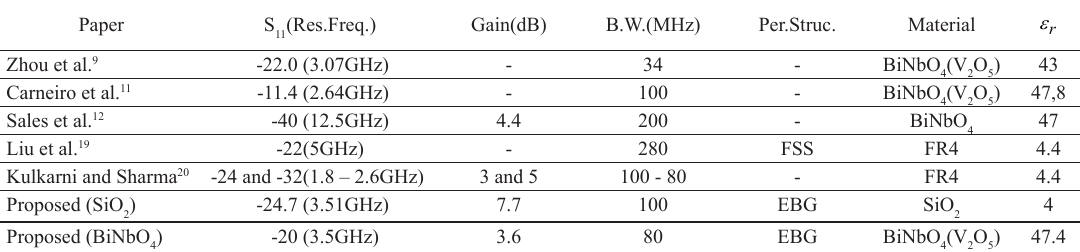
, gain, B.W., use of periodic structures, substrate material and r ε parameters, of recently papers that use high Table 2. Comparison of S 11 permittivity materials in microvawe aplications, with ours results .